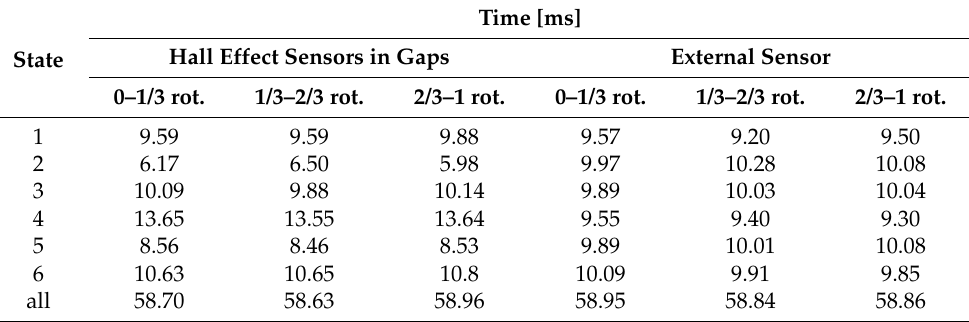
Table 2. Comparison of the duration times of individual commutation states determined by hall sensors installed in grooves and hall sensors installed in an external sensor for a rotating motor with a speed of 340 rpm. Time [ms] Hall Effect Sensors in Gaps External Sensor State 0–1/3 rot. 1/3–2/3